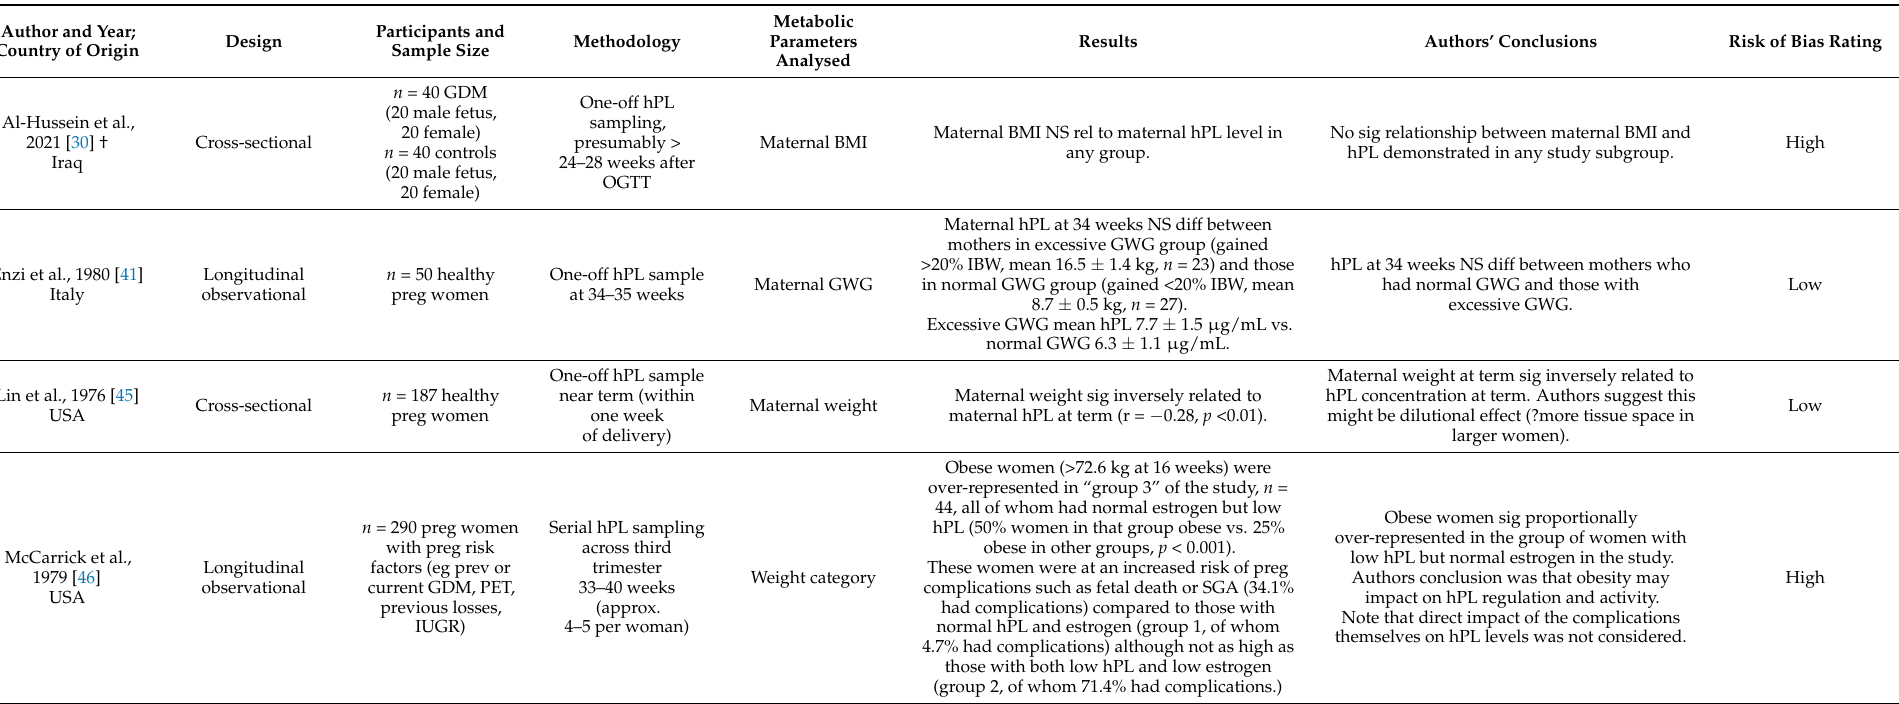
Table A4. Studies examining hPL in relation to body mass index and/or gestational weight gain in pregnancy—4